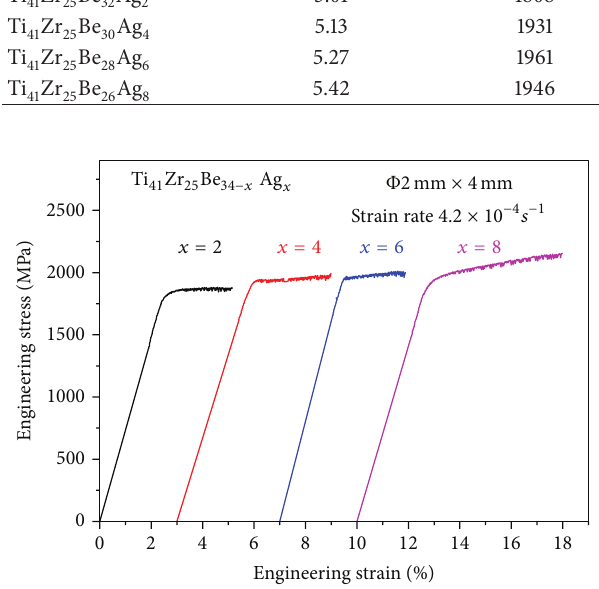
Figure 3: Compressive stress-strain curves at room temperature for Ag ( x = 2, 4, 6, 8 at.%) glassy samples. Ti 41 Zr 25 Be 34− x x